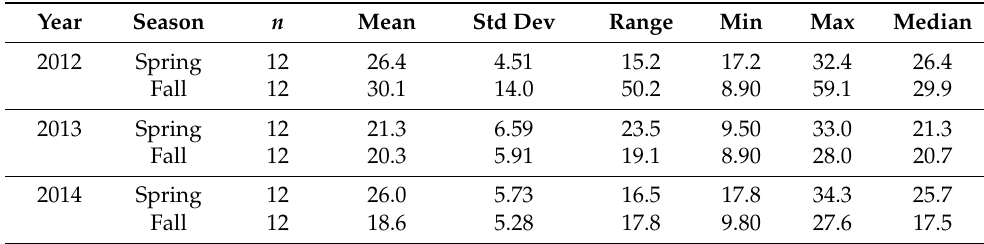
Table 2. Descriptive statistics for sediment copper SEM concentrations ( µ g/g dry weight) from 12 Cache Slough (CA) sample sites for the years